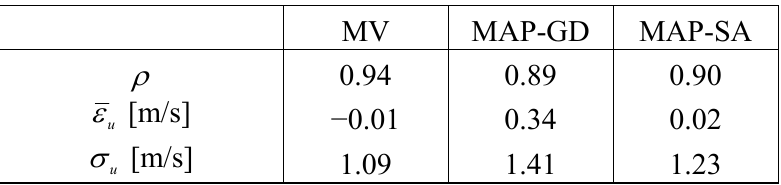
~ uu  (b). In panel a, 1919